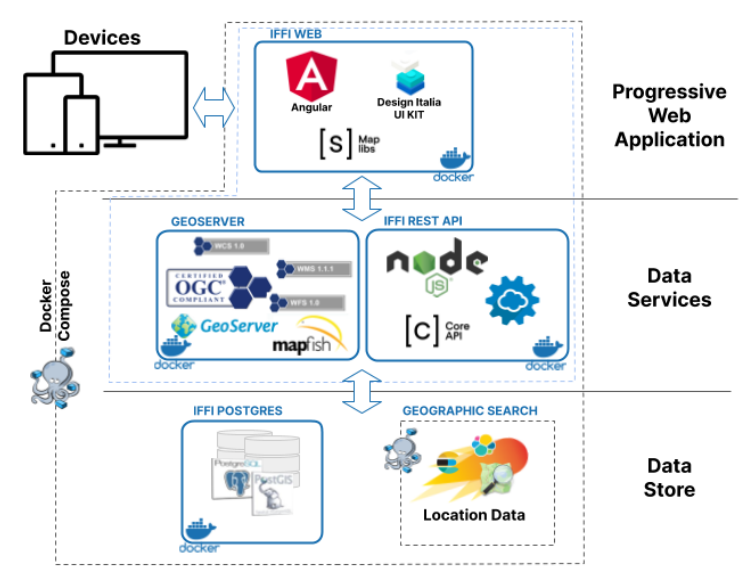
Figure 9. Architecture of the IdroGEO